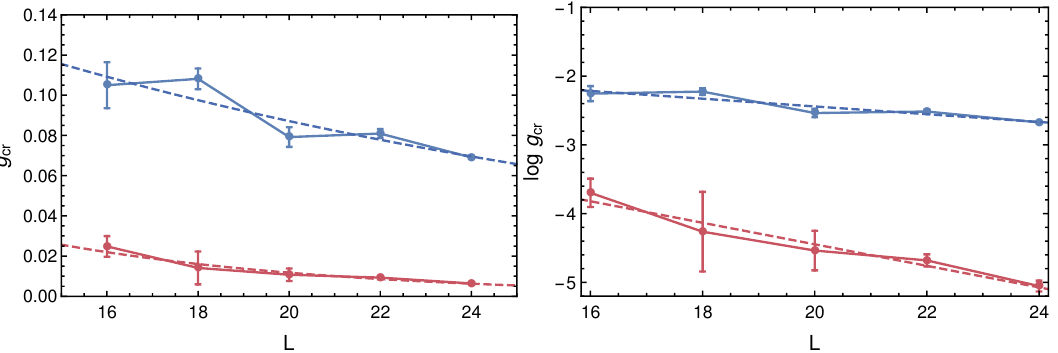
Figure 10: The crossover scale as a function of the volume for the current (blue markers) and NNNI perturbations (red markers) for ∆ = 1.6 (gapped phase, antifer- romagnetic) on normal (left) and log scale (right). Dashed lines correspond to the fitted exponentials.